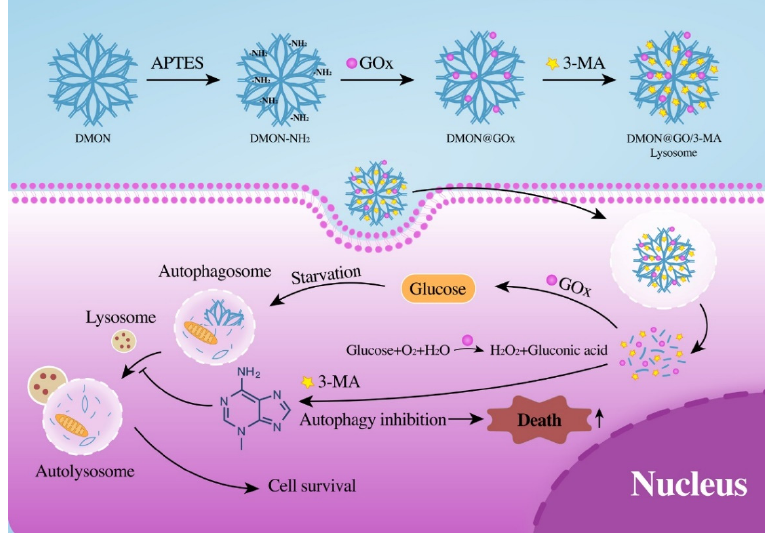
Figure 1. Schematic representation of the functional pattern of DMON@GOx/3-MA. Autophagy in- hibitor 3-MA released from DMON@GOx/3-MA enhances GOx-induced starvation therapy in tu- mor cells.